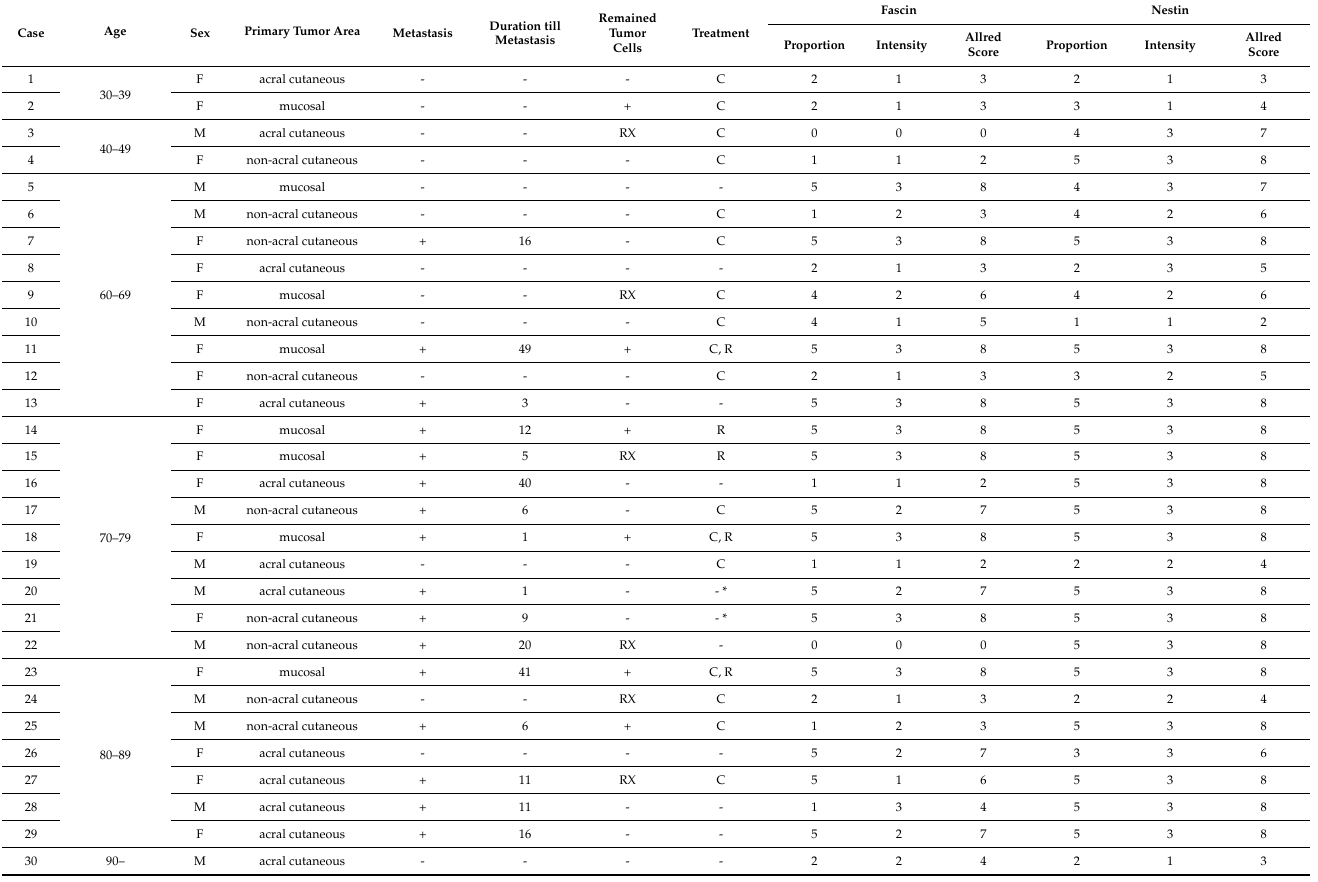
Table 1. Clinical and immunohistochemical backgrounds of